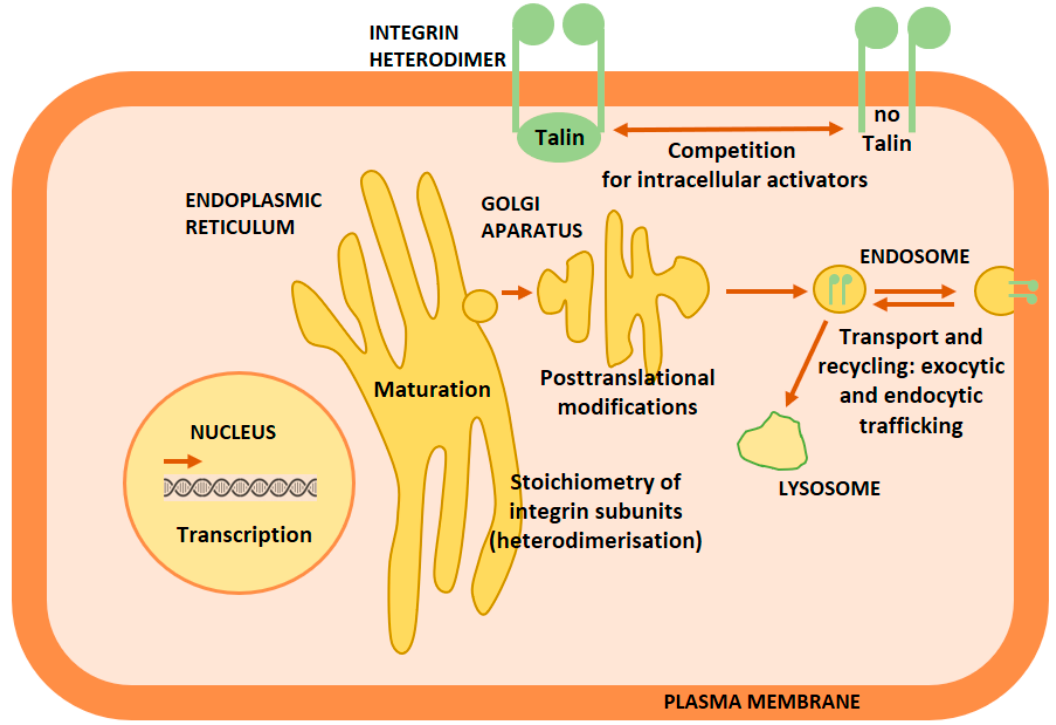
Figure 4. Integrin crosstalk mechanisms. The mechanisms act on several levels: on the level of changes in stoichiometry of integrin subunits, transcription, but also on the level of changes of integrin proteins (maturation, post-translational modifications, transport and recycling) and the activation of an integrin. Integrin crosstalk mechanisms are in lower case.